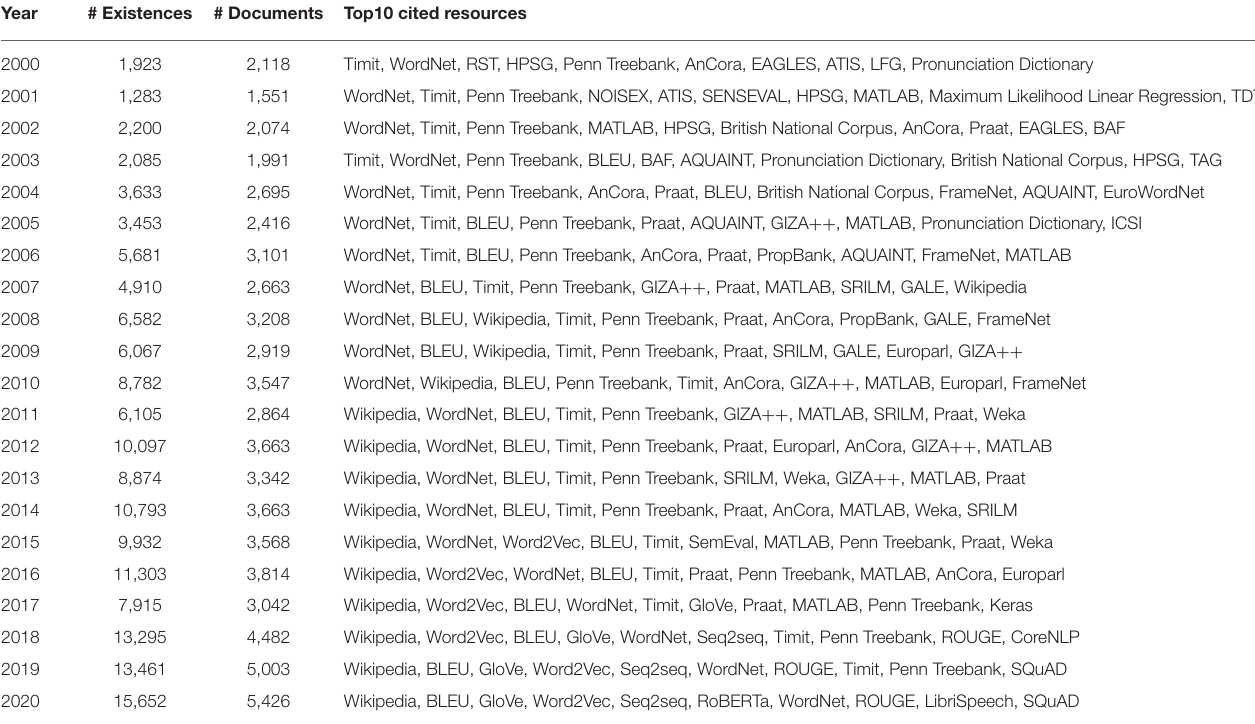
TABLE 30 | Ranked top 10 mentioned LRE Map language resources per year (2000–2020). Year